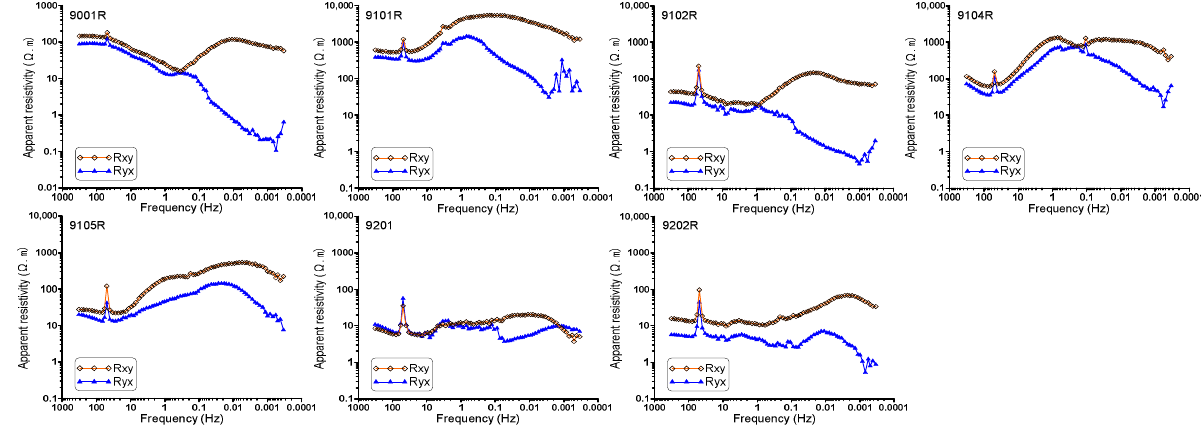
Figure A3. Apparent resistivity curves of seven magnetotelluric (MT) stations that are not on Lines 3 and 5. The locations of these stations are shown in Figure 2.